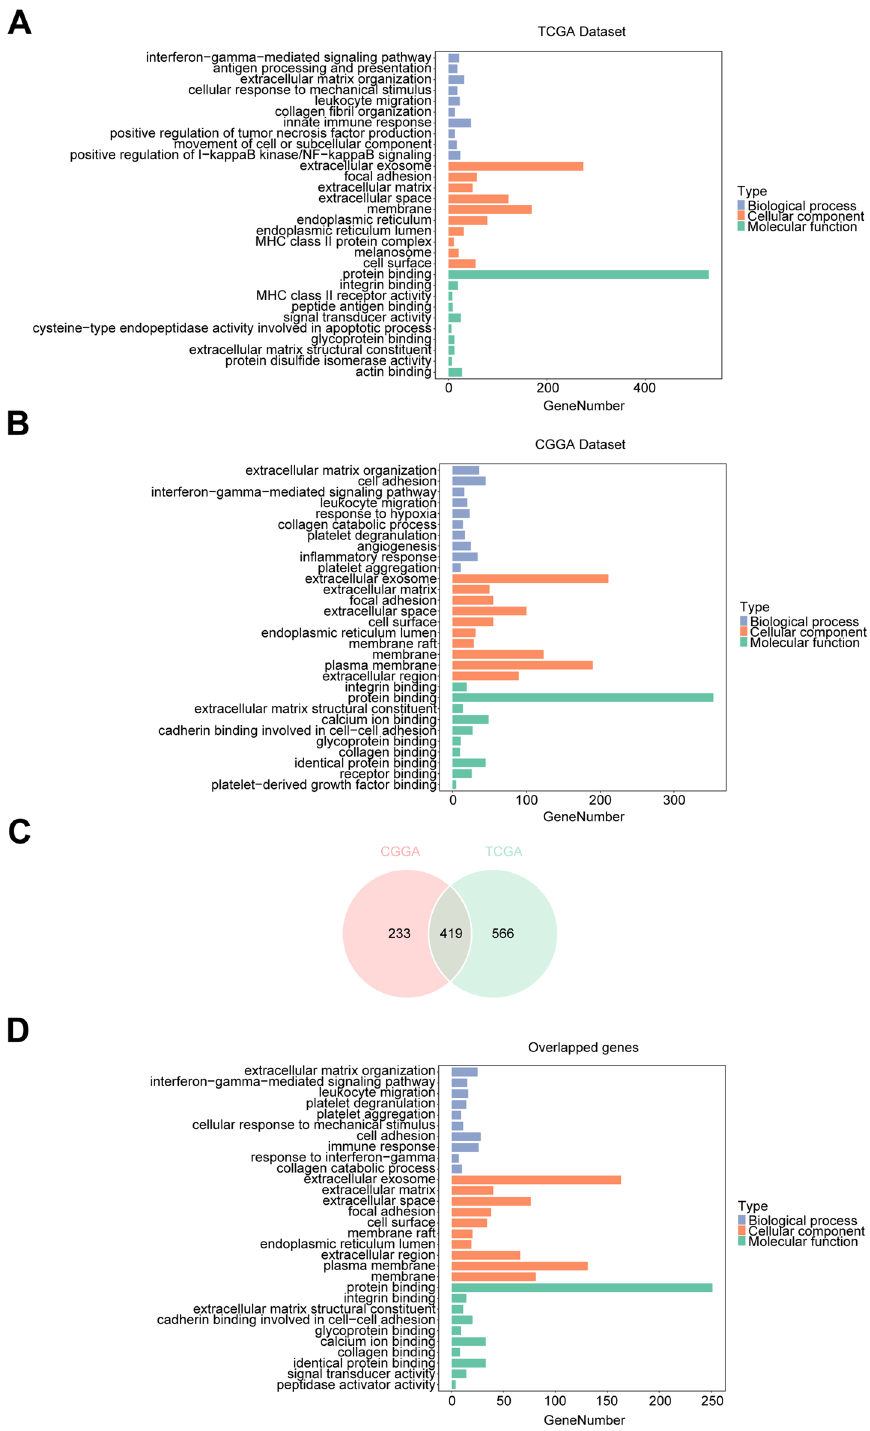
Figure 5. GO analysis of ANXA2-related characteristics in glioma. The results revealed that ANXA2 is involved in some important biological processes in glioma based on TCGA ( A ) and CGGA ( B ) datasets. GO analysis of 419 genes common to both datasets was used for validation ( C,D